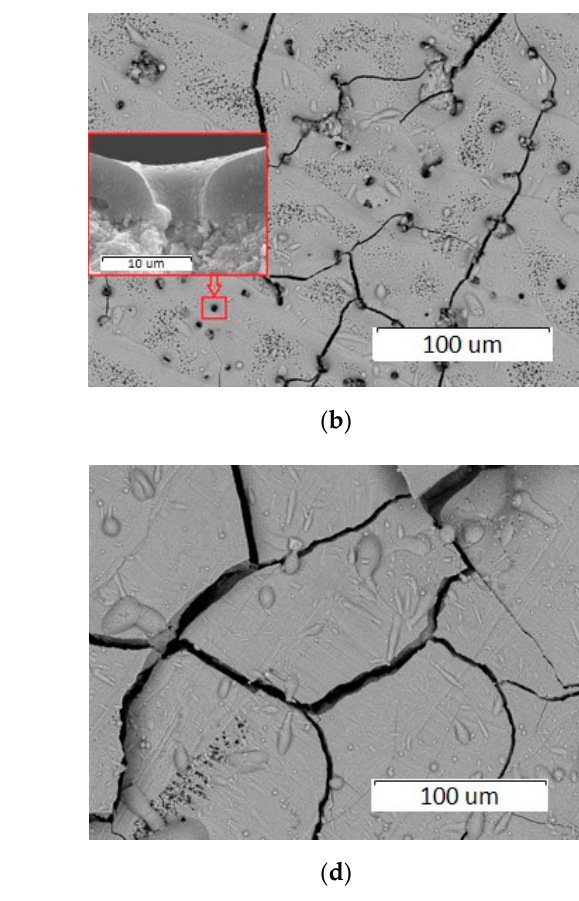
Figure 9. SEM images of pellet surface treated by a 0.2 mm laser spot at 4 W and at different scanning speeds, mm/s: ( a ) 700; ( b ) 500; ( c ) 300; and ( d ) 100. The inset shows a cross section of the specified area.